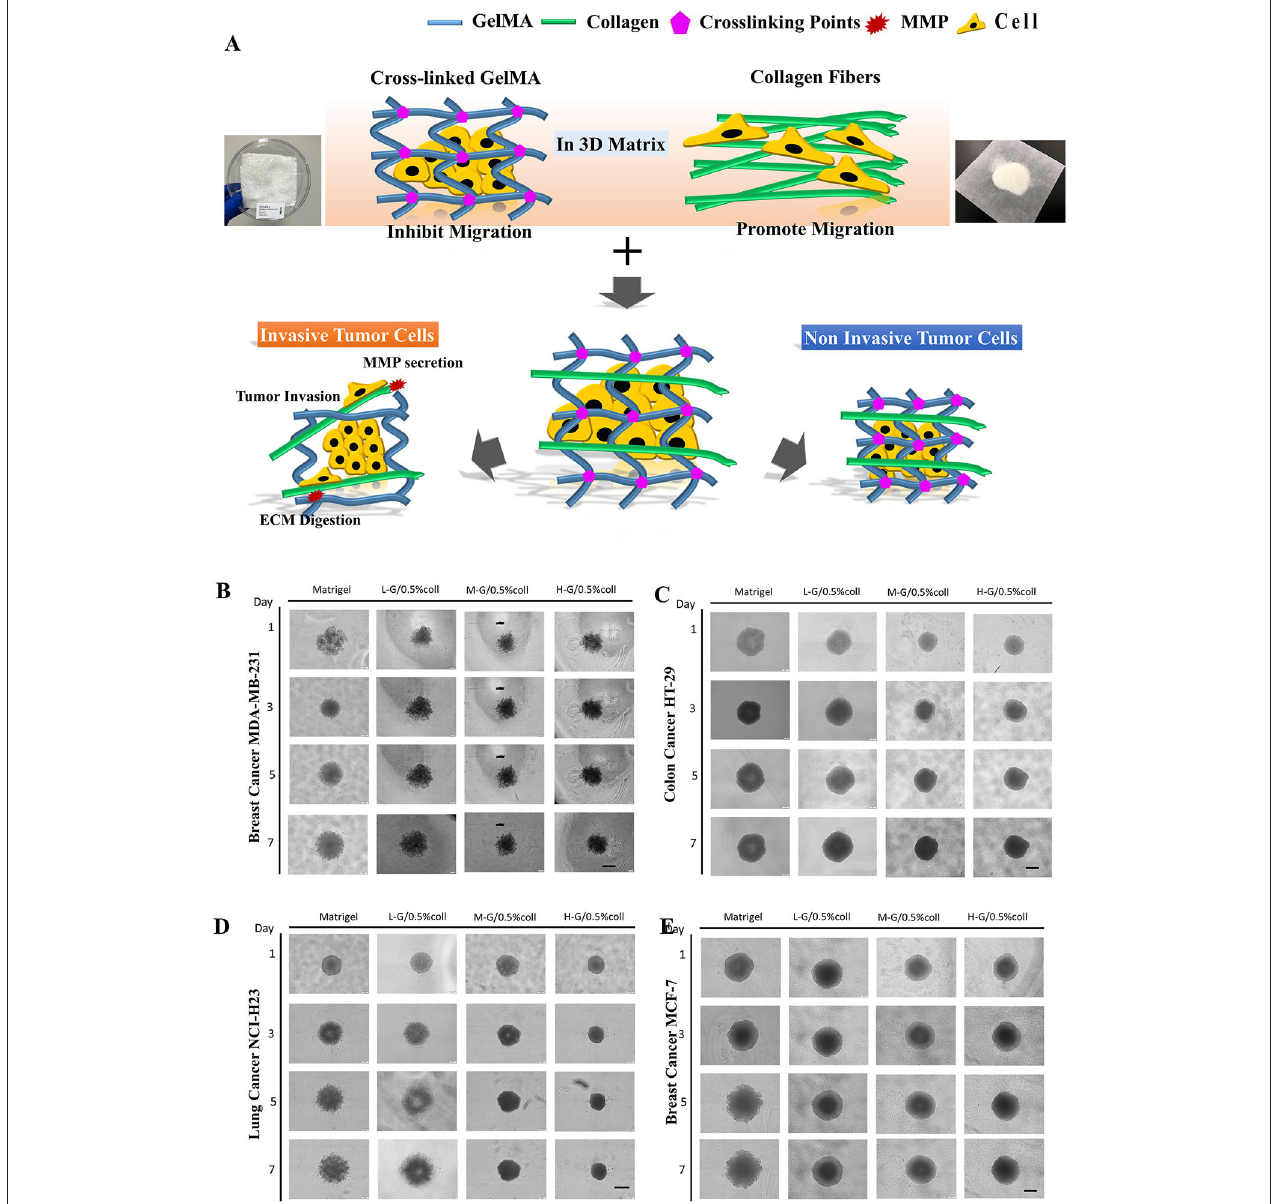
FIGURE 3 | Tumor spheroid invasion in composite hydrogel. (A) Schematic illustration of Tumor invasion inside of hydrogels. GelMA hydrogel inhibits cell invasion while collagen promotes cell invasion. The composite hydrogel containing both GelMA and collagen component formed a 3D environment that allows invasive cells to digest matrix and invade, while the non-invasive cells were confined in their original positions. (B–E) are the comparison of cellular behavior among four types of cancer cells in Matrigel and in composite hydrogels, including: invasive breast cancer cells (MDA-MB231), less-invasive breast cancer cells (MCF7), invasive lung cancer cells (NCI-H23), and less-invasive colon cancer cells (HT29), respectively. Scale bar: 400 µ